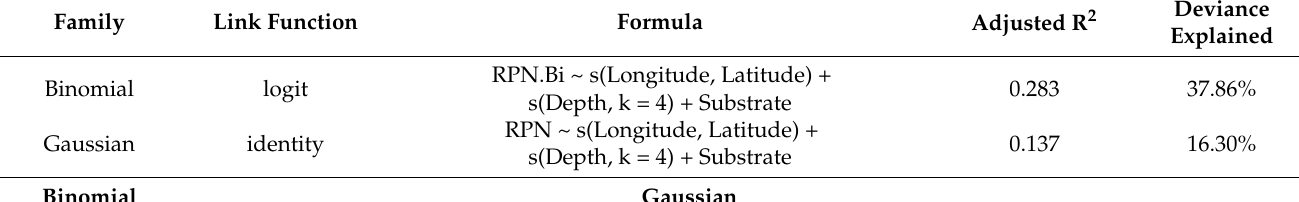
Table 1. Results of the generalized additive models for the thornback ray Raja clavata abundances derived from the scientific surveys (1996–2019) in the Azores. Bottom type: coarse sediment (C. Sed, termed as Intercept), mixed sediment (Mix.Sed), mud (Mud), muddy sand (Mud.S), rock (Rock), sand (Sand), and sandy mud (Sand.M). Family